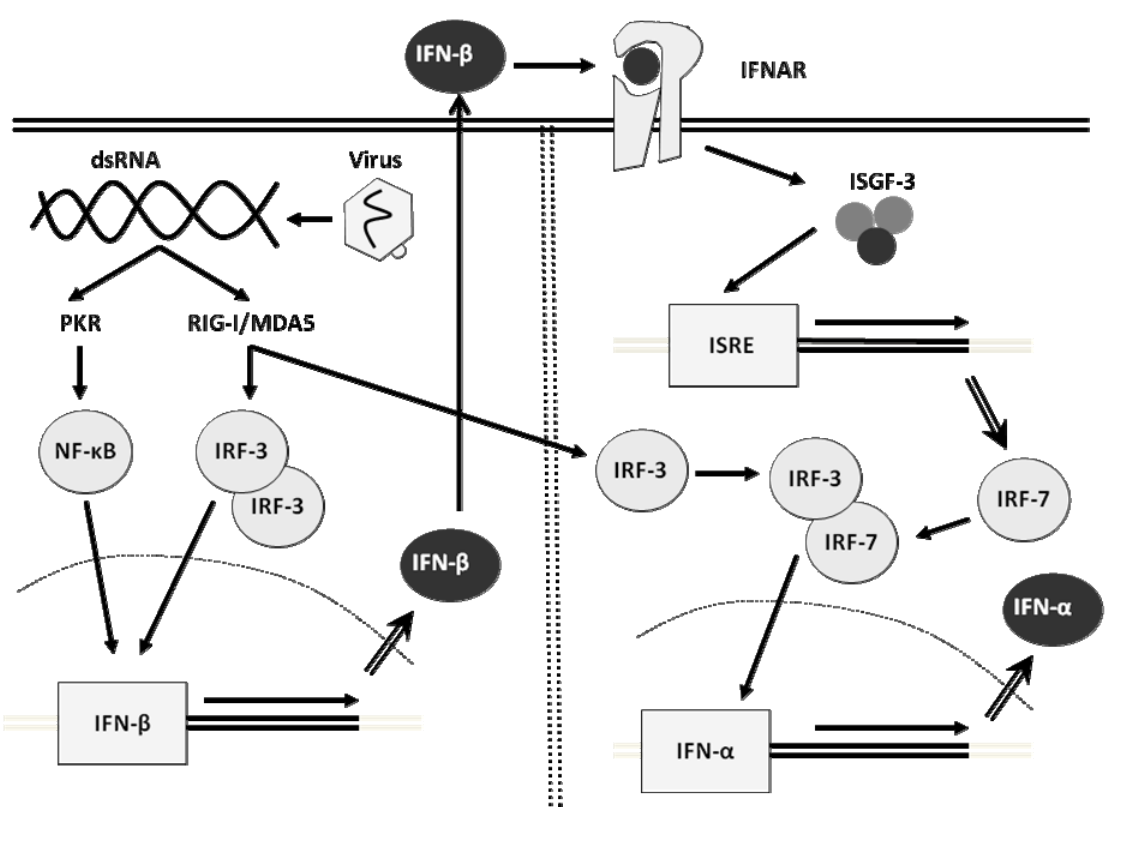
Figure 2. Simplified mechanism of regulation of the induction of the interferon genes in most cells. PKR , RNA dependent protein kinase; IRF , interferon regulatory factor; ISGF , IFN-stimulated gene factor; IFNAR , interferon alpha receptor; ISRE , interferon stimulated response elements. Ovals represent proteins, squares represent